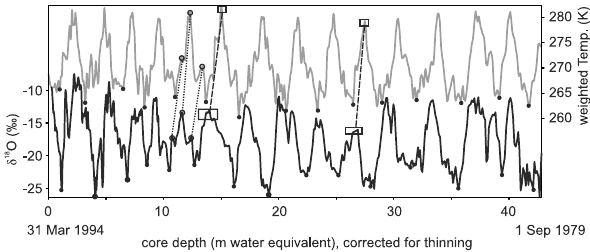
Fig. 4. Sample-by-sample depiction of the ice core δ 18 O (bottom) as well as PWT (top, using Great St Bernard station data). Black dots denote the cross dating using wiggle matching, open circles show examples of matching sub-seasonal features. Squares show examples for possible melting